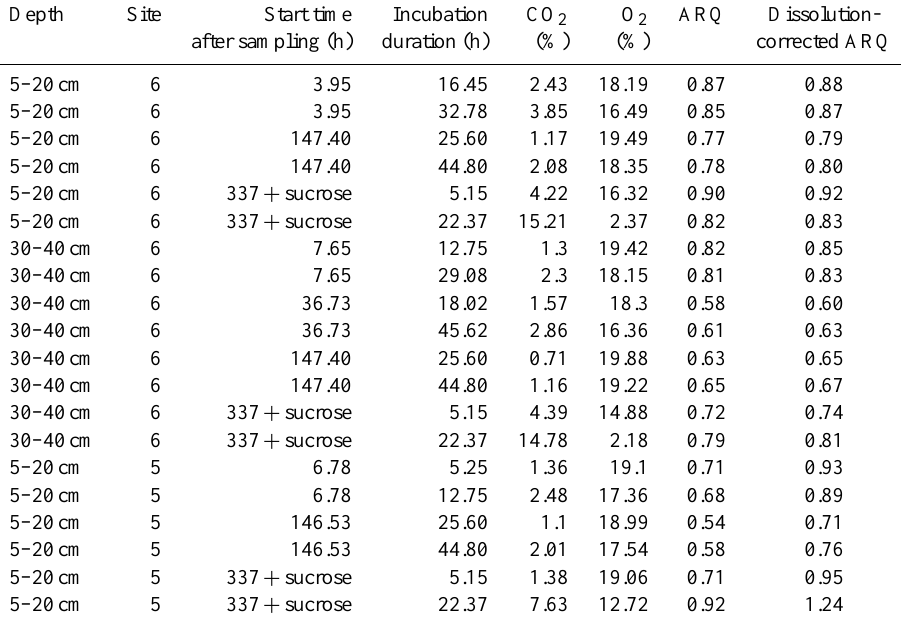
Table 2. Results of the soil incubation experiments with alpine forest soils. The soils were sieved to remove roots before incubation. The apparent respiratory quotient (ARQ) values declined with time since sampling and increase following the addition of sucrose, with good agreement between pair measurements. In order to calculate the dissolution-corrected ARQ the dissolved inorganic carbon in the soil solution was calculated, based on the CO 2 partial pressure, the temperature, and the soil solution